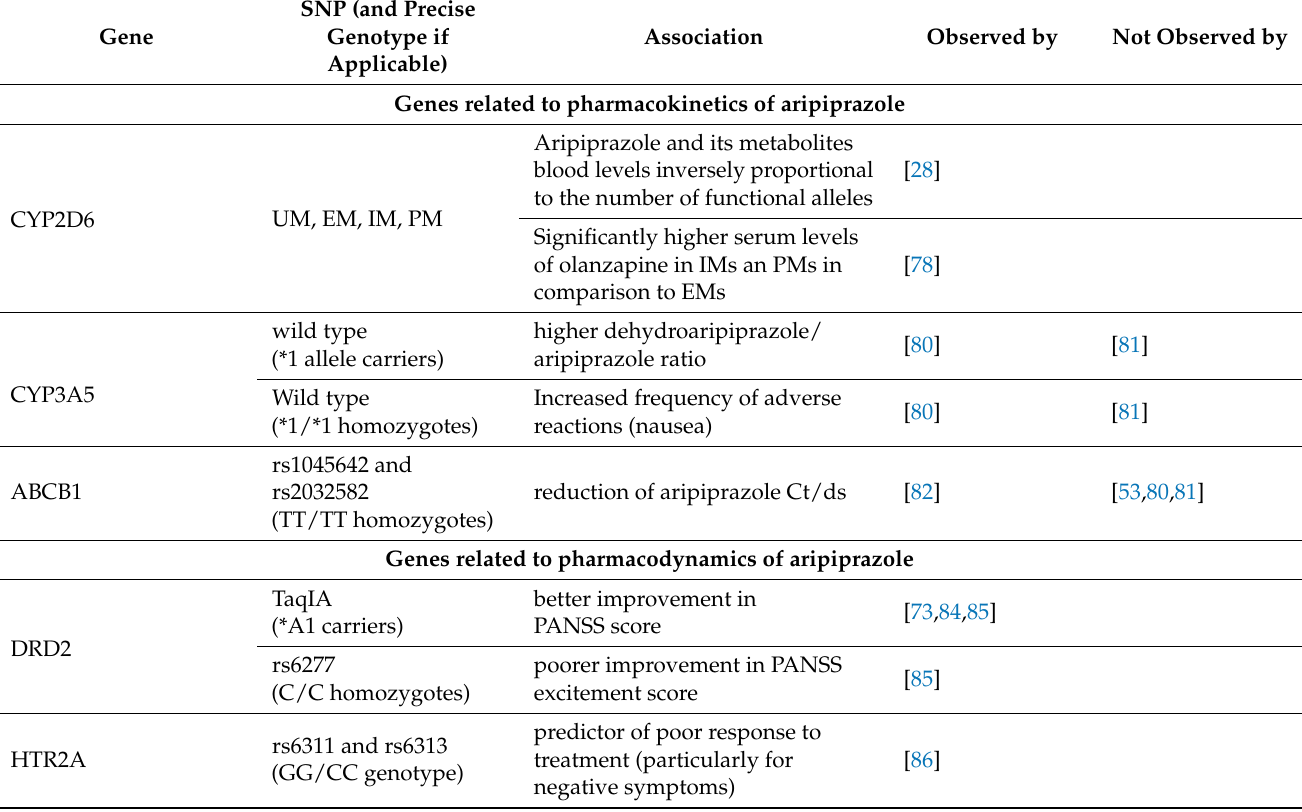
Table 4. Summary of gene polymorphisms which might impact aripiprazole